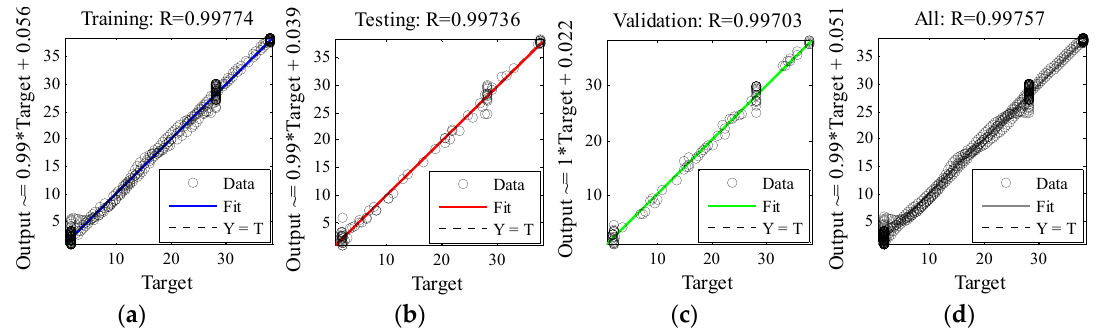
Figure 20. Regression coefficient (R) of the ANN algorithm for ( a ) training, ( b ) testing, ( c ) validation, and ( d ) all data for the NLOS environments.